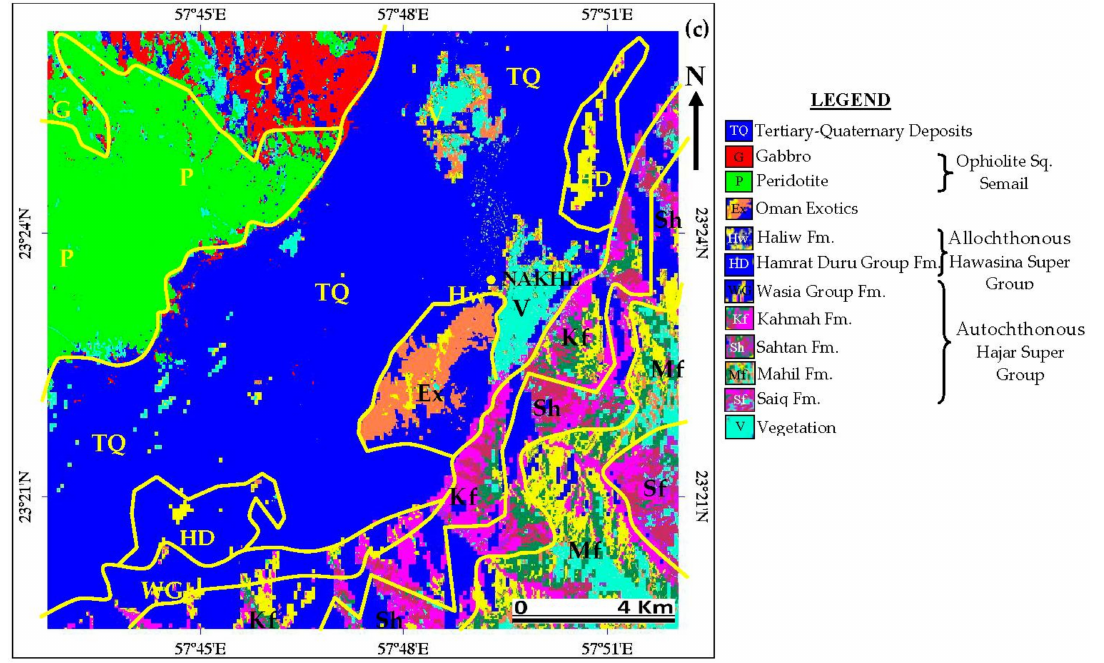
Figure 4. Images of ( a ) Maximum Likelihood Classification; ( b ) Spectral Angle Mapper and ( c ) Spectral Information Divergence show the occurrence and spatial distribution of lithological classes of the Nakhl